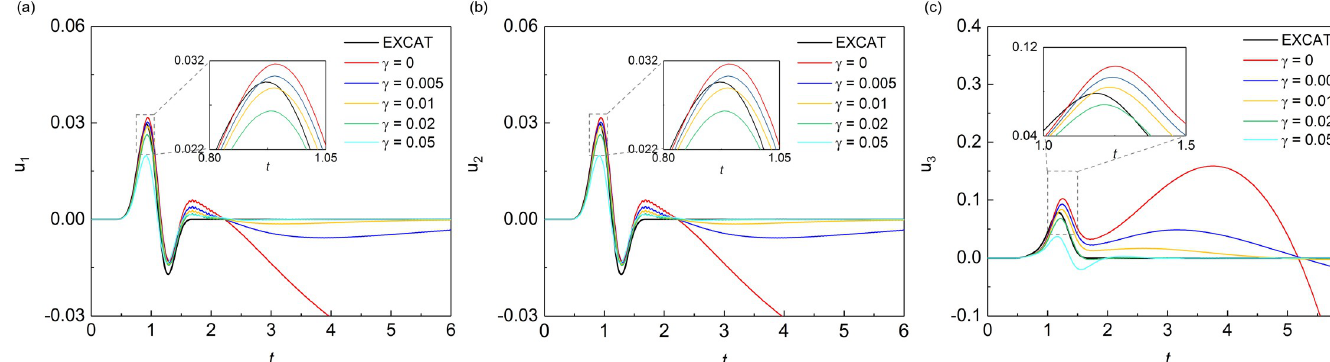
Fig 8. Displacement time-histories of observation point B